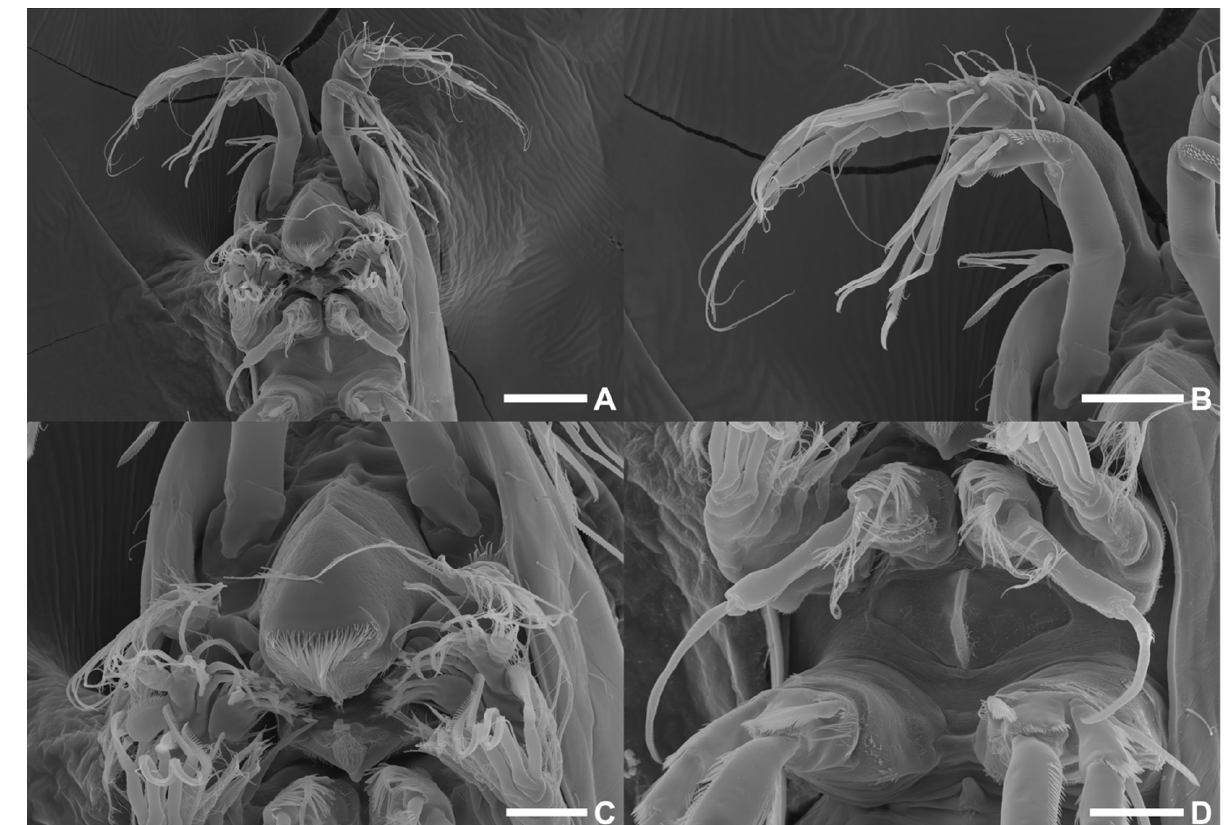
Figure 24. Scanning electron microscopy images of Phyllopodopsyllus similis sp. nov. female (paratype 4) in ventral view: ( A ) cephalothorax; ( B ) antennule and antenna; ( C ) mouth parts around oral opening; ( D ) maxilliped. Scale bars: ( A ) 50 µm; ( B ) 30 µm; ( C , D ) 20 µm.